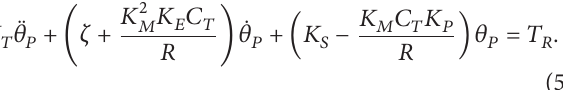
Figure 11: The relationship between the steering wheel torque and the steering wheel angle in the antivibration control.